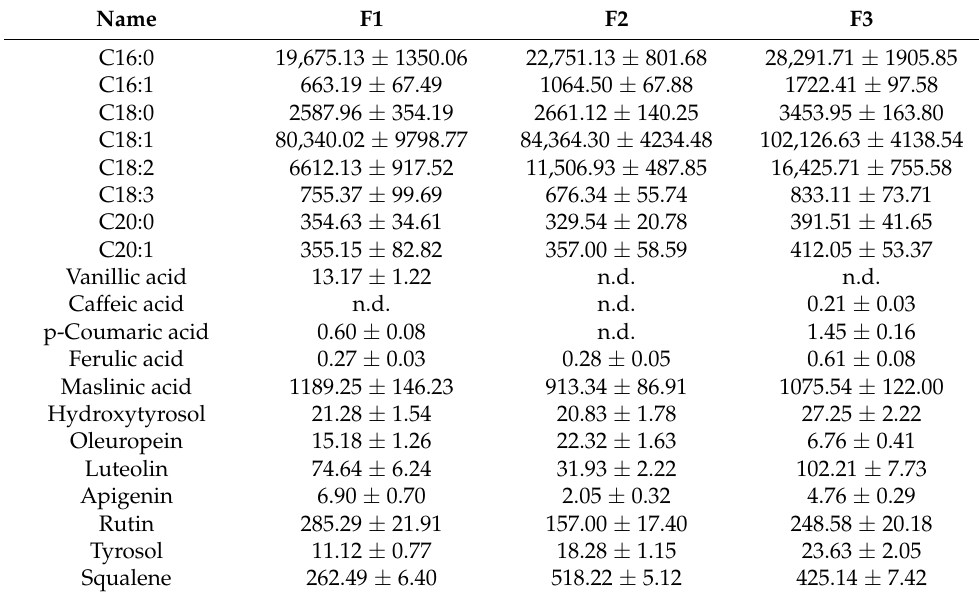
Figure 1. Targeted metabolomics analysis of olive fruits at different maturity stages. ( A ) Fatty acid contents determined by GC/MS-based targeted metabolomics. ( B ) Minor components (such as polyphenols) contents measured by LC/MS-based targeted metabolomics. “µg/g” for fresh weight; ( B ) has the same units on the y axis as ( A ). Table 1. Metabolite contents in fruits at different maturity stages determined by targeted metabolomics analyses. Six biological replicates were used to determine contents within groups. Data are shown as mean ± SD (μg/g). n.d., not detected.